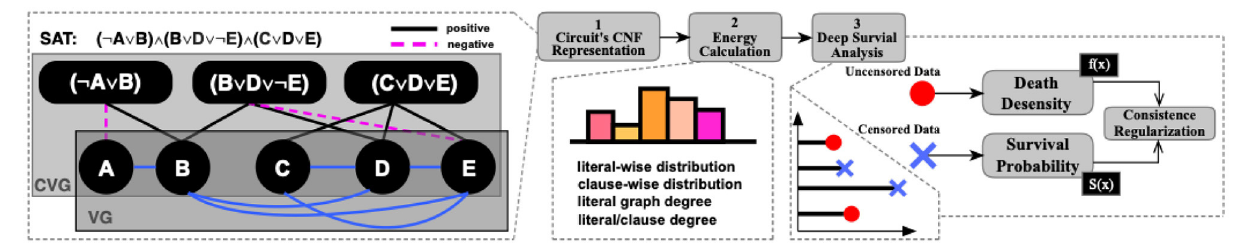
FIGURE 2 | Architecture of Deep Survival Analysis with Graph (DSAG): (1) extract Variable Graph/Clause-Variable Graph (VG/CVG) based on conjunctive normal form (CNF) formula; (2) apply energy kernel to aggregate dynamic-size features; (3) employ survival analysis to exploit censored data with uncensored